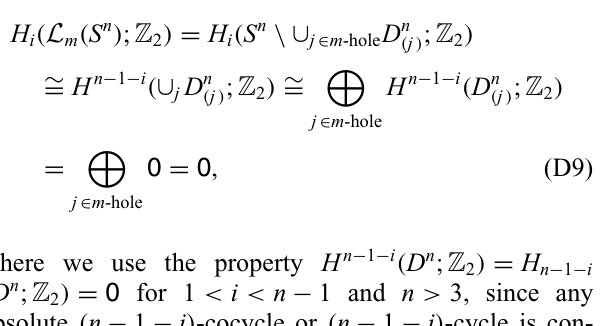
FIG. 39. An illustration of the decomposition of a punctured n -sphere S n with both e -holes and m -holes into a punctured n -sphere containing only e -holes and another containing only m -holes. One first constructs a spanning tree connecting all the e -holes and then thickens the spanning tree into a punctured n -ball. The entire punctured n -sphere is hence equivalent to the gluing of two punctured n -balls with only e -holes and m -holes, respectively, which is in turn equivalent to the connected sum of two punctured n